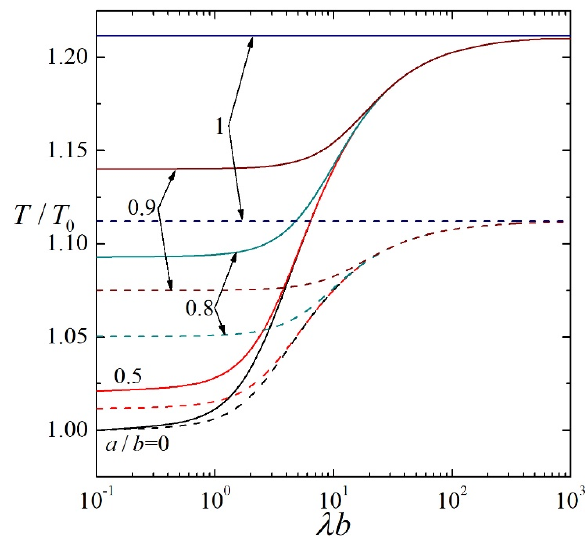
/ TT Figure 5. Normalized torque 0 for a soft sphere rotating about a diameter perpendicular to two planar walls vs. the ratio of the core-to-particle radii